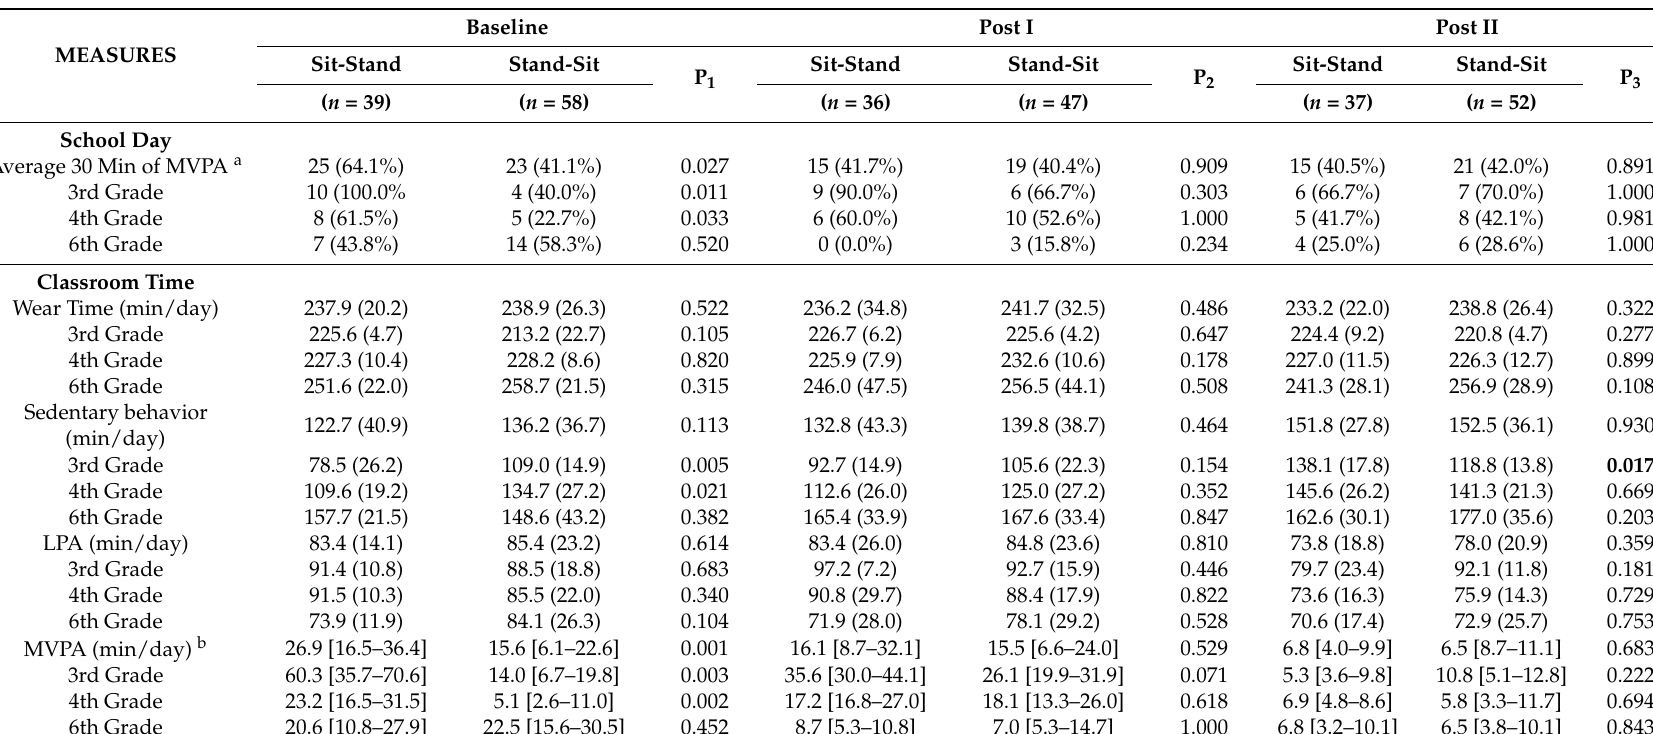
Table 2. Physical activity and sedentary behavior characteristics during classroom in those using a sitting desk versus a stand-biased desk (Mean